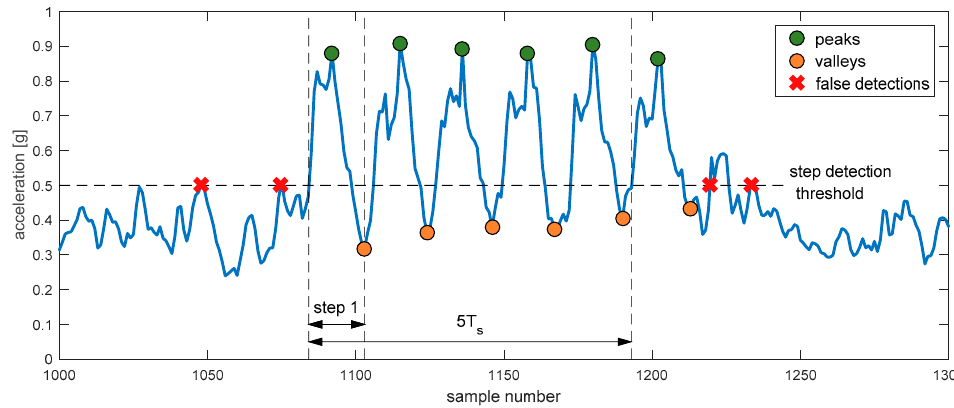
Figure 9. Acceleration measured for a sequence of six steps. Detected peaks and valleys are marked with green and red dots respectively. False step detections, which would occur for a simple threshold algorithm, are marked with red crosses.